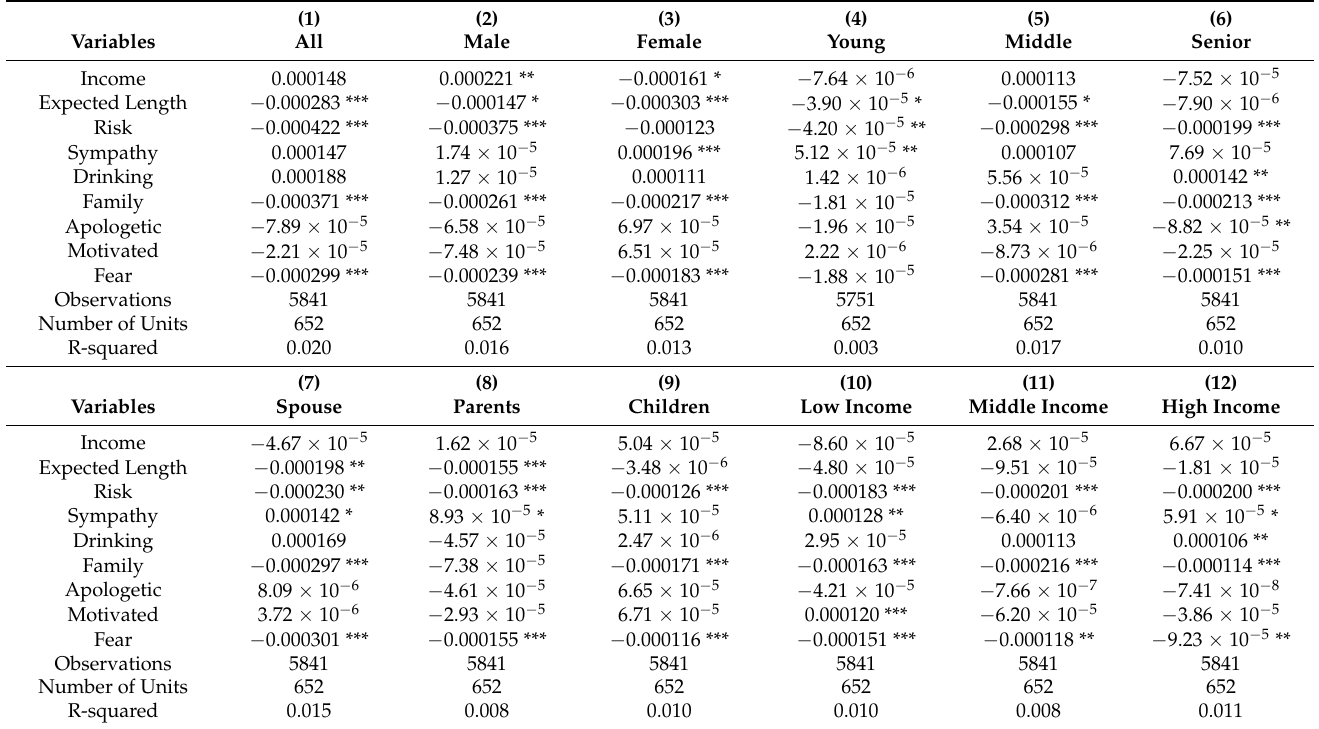
Table 4. Estimation results with limited